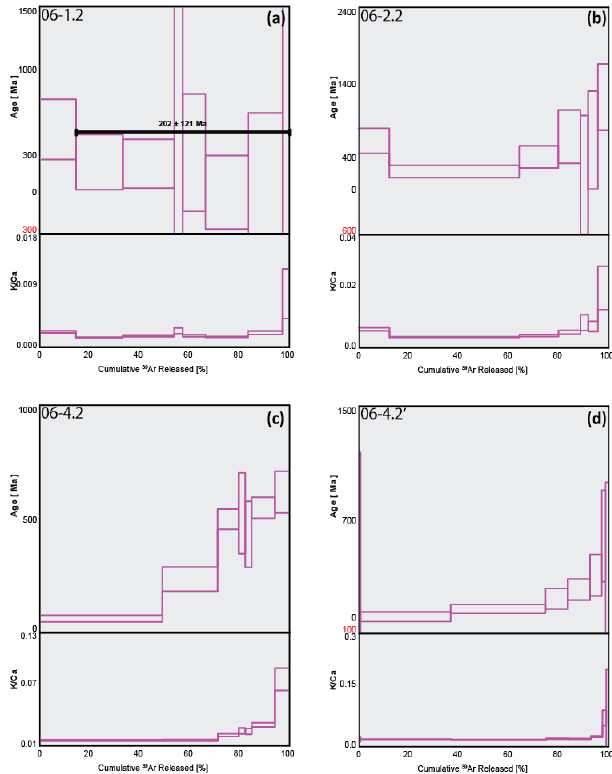
Figure 6. Combined age spectra and K / Ca plots for samples 06- 1.2 (a) , 06-2.2 (b) , 06-4.2 (c) , and 06-4.2’ (d) . The thickness of individual spectra blocks is indicative of measurement